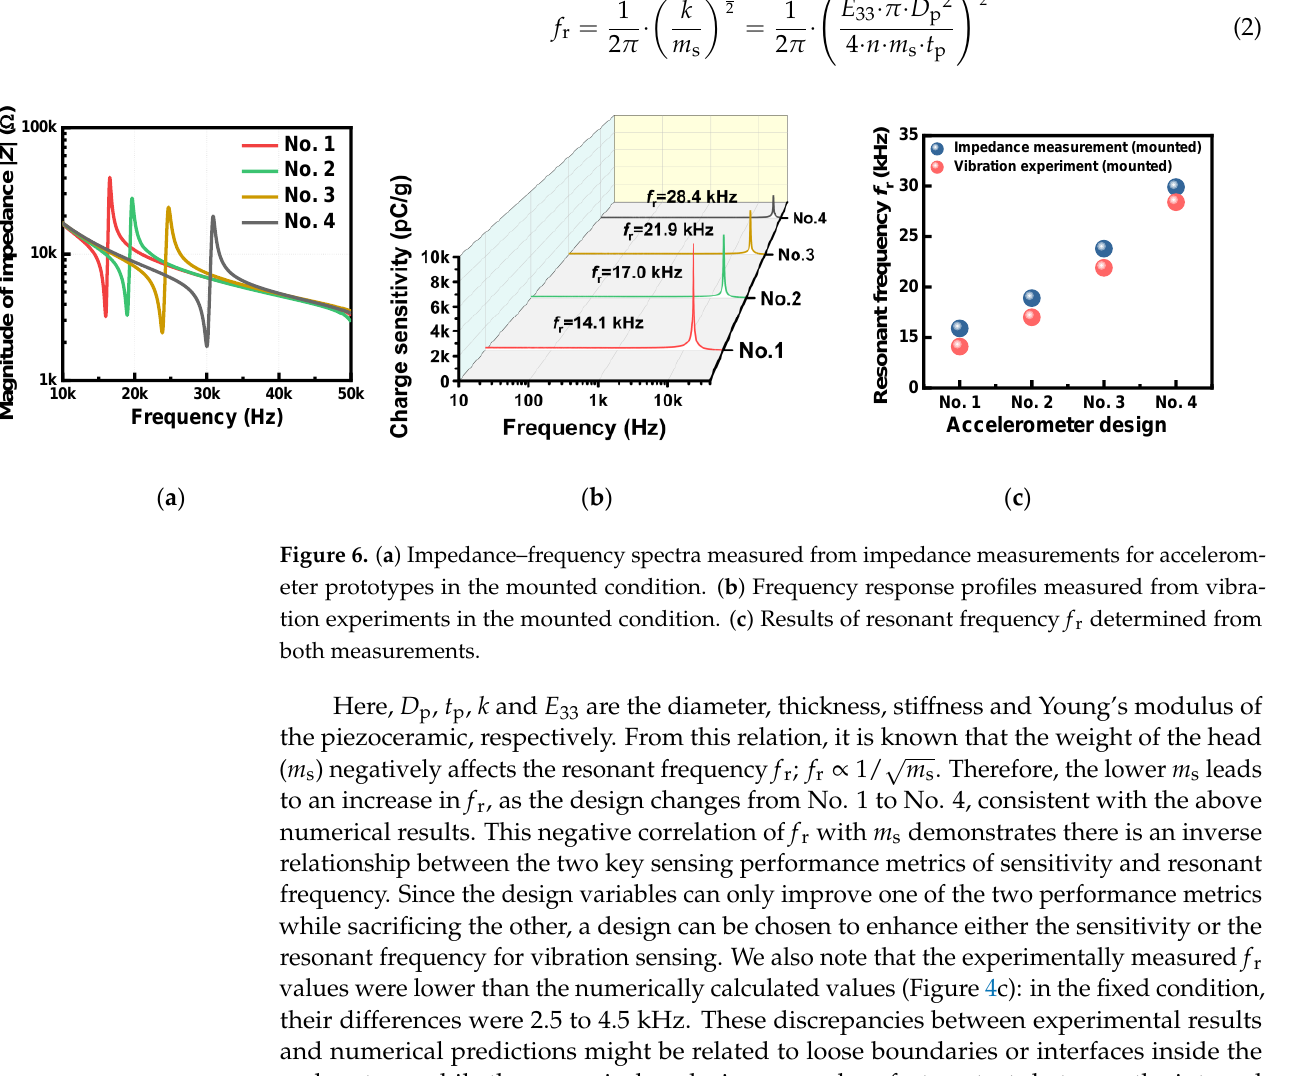
Table 4. Frequency response properties of the accelerometer prototypes obtained from vibration experiments.